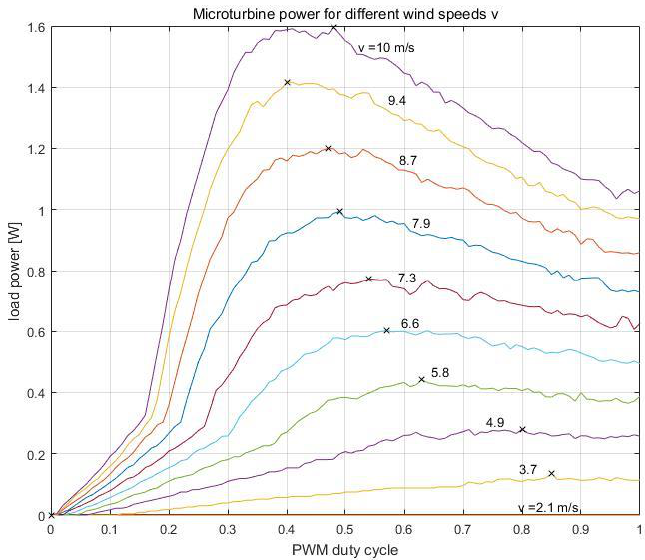
Figure 11. The power generated by a wind turbine for a non-linear load, as a function of the control value—duty cycle of the PWM signal, for different wind